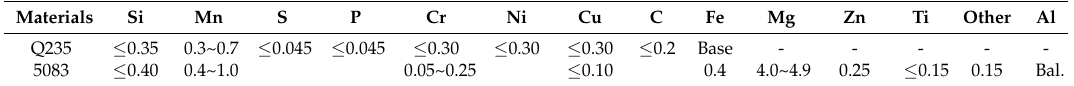
Table 1. Nominal composition of Q235steel and AA5083 alloy (wt %).